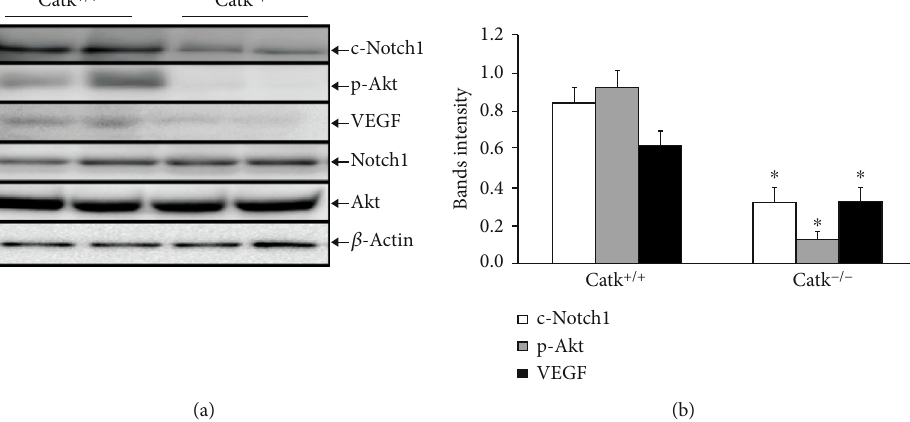
Figure 6: The levels of the targeted proteins in the ischemic muscles of aged CatK +/+ and CatK – / – mice. (a, b) Representative immunoblot images and combined quantitative data show the levels of the c-Notch1, p-Akt, and VEGF proteins in the ischemic muscles of two groups. Results are mean ± SEM ( n = 3 ). ∗ p < 0 : 05 by one-way ANOVA and Tukey ’ s post hoc